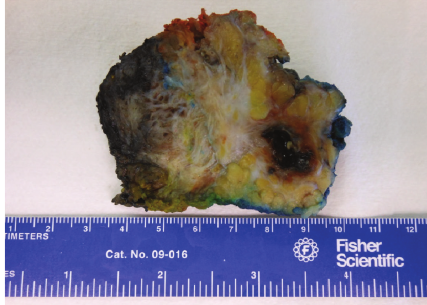
Figure 3: Resected abdominal wall mass with desmoid and endometrioma features.